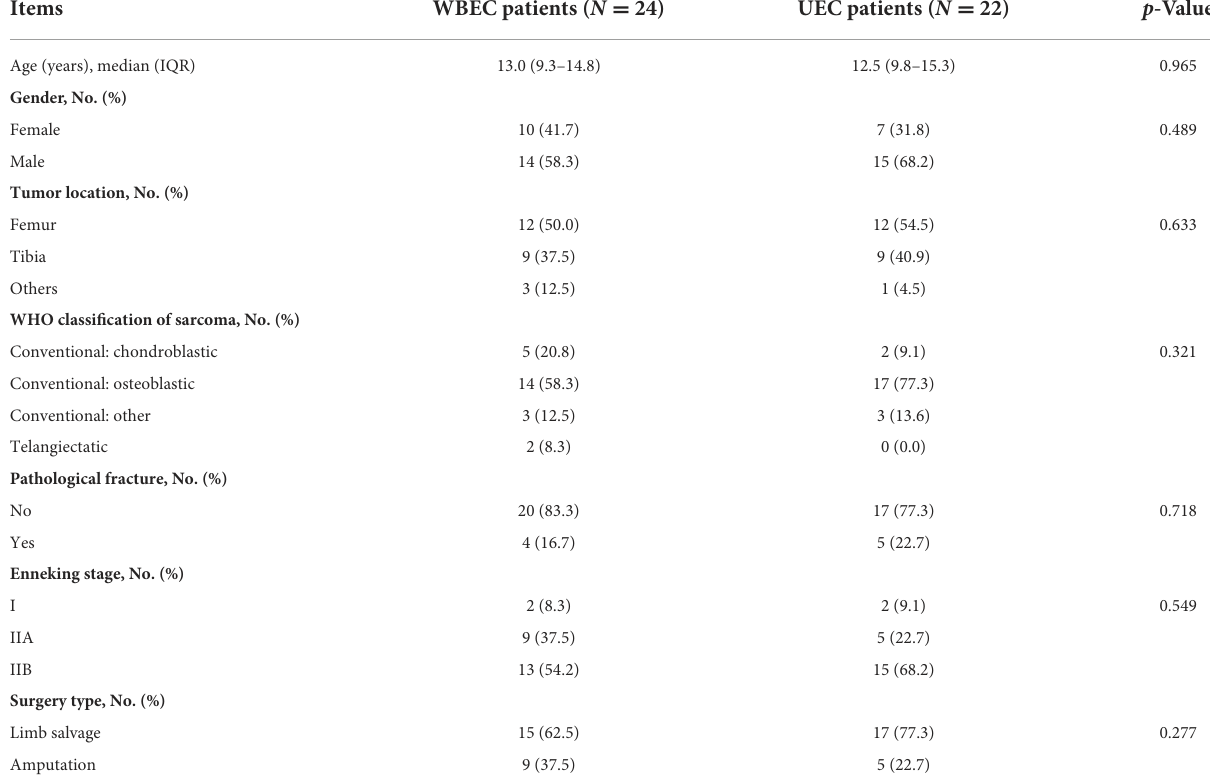
TABLE 1 Clinical characteristics of